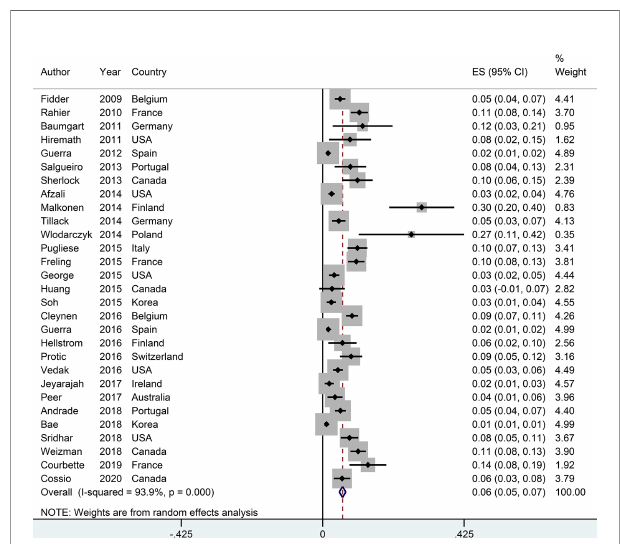
FIGURE 1 | Forest plots of incidence of psoriasiform lesions and/or psoriasis associated with anti-tumor necrosis factor therapy in in fl ammatory bowel disease patients.